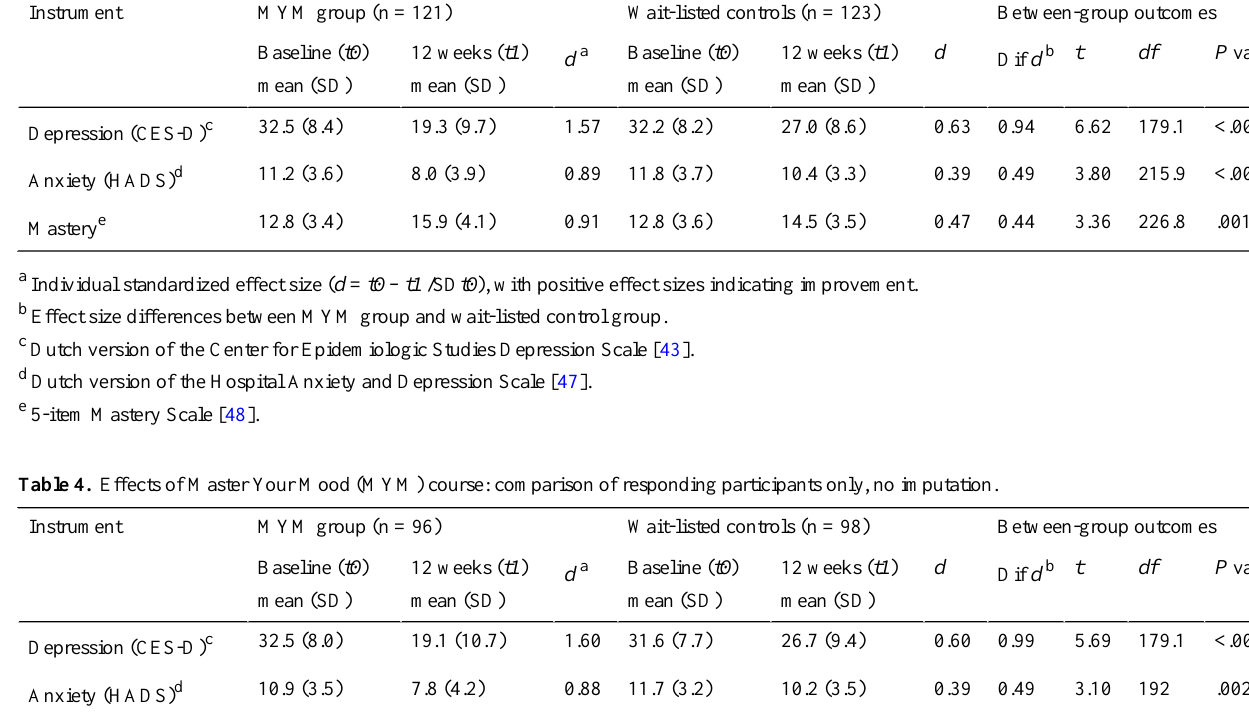
Between-group outcomesWait-listed controls (n = 123)MYM group (n = 121)Instrument